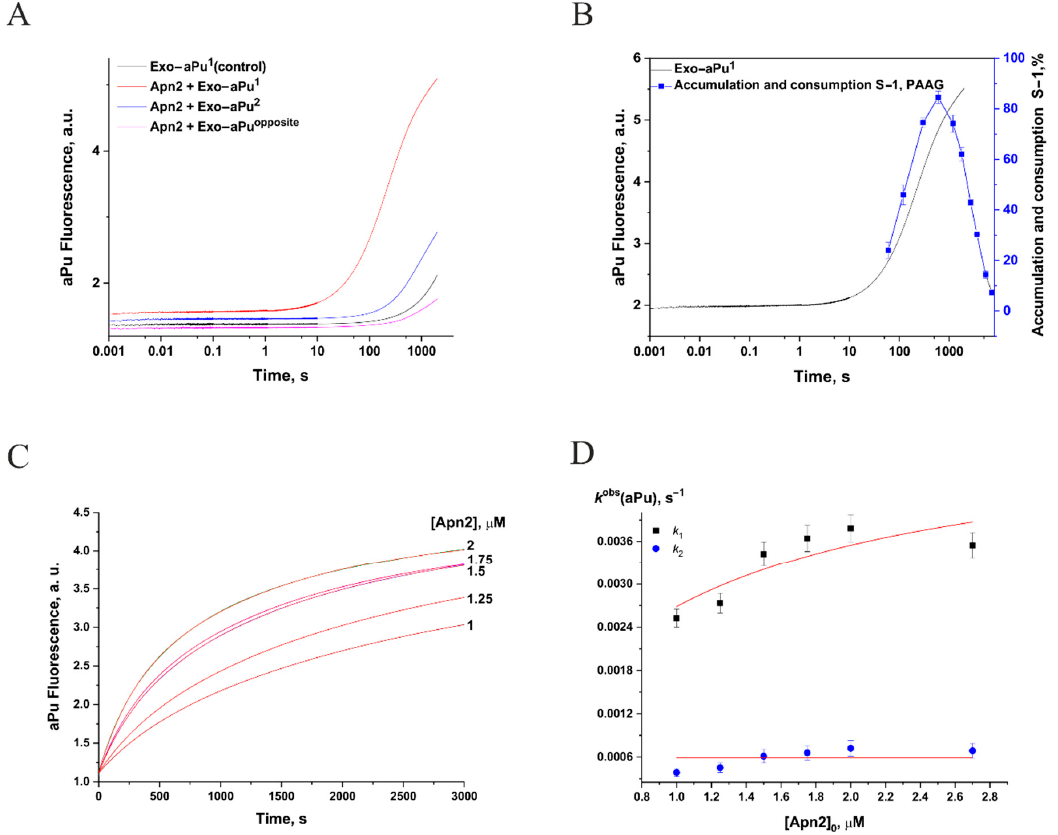
Figure 7. ( A ) Changes in fluorescence intensity of aPu during the interaction of Apn2 with Exo–aPu 1 , Exo–aPu 2 , or Exo–aPu opposite ([S] = 1 μ M, [Apn2] = 2 μ M, Т = 37 °C). ( B ) The comparison between kinetic curves built by means of the change in aPu fluorescence intensity during the interaction of Apn2 with Exo–aPu 1 and those built by means of the accumulation of reaction products in a PAAG ([S] = 1 μ M, [E] = 2 μ M, T = 37°C). ( C ) Changes in fluorescence intensity of aPu during the interaction of Apn2 with Exo–aPu 1 ([S] = 1 μ M, [Apn2] was varied from 1 to 2 μ M). ( D ) The dependence of